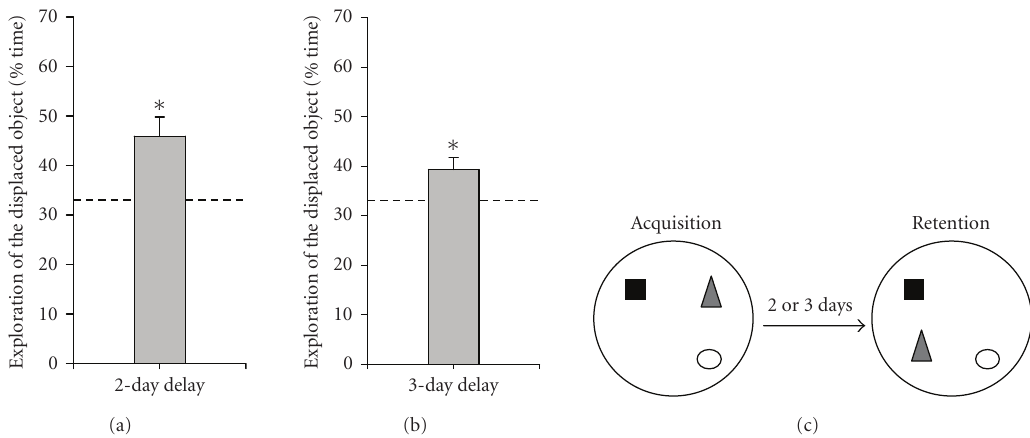
Figure 1: Performance at the 2-day and 3-day retention intervals of the object-place recognition memory task. At both (a) 2-day and (b) 3-day delays after acquisition, rats ( n = 15 in each case) showed preferential exploration of the displaced object. (c) Schematic representation of the task. Asterisks indicate P ≤ . 05 compared with chance level (dashed line, 33.3%). Data are presented as mean ± SEM.